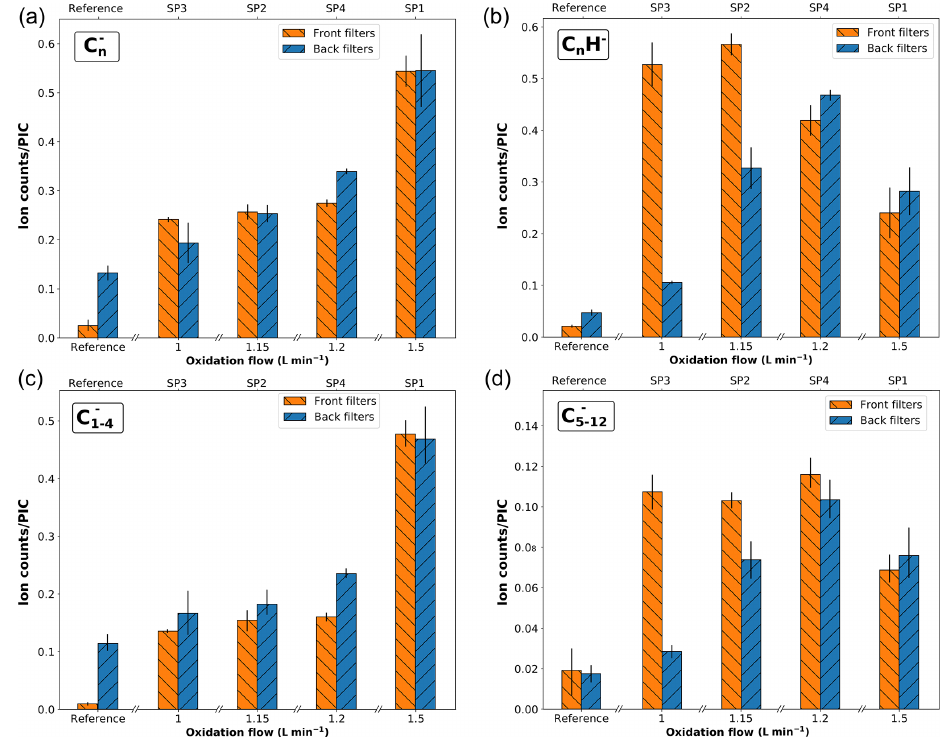
Figure 8. Variation in the signal of various markers, as derived from SIMS spectra. The panels represent the total peak areas of the following families: (a) C − n , (b) C n H − , (c) C − , and (d) C − . All values are normalized to the partial ion count (PIC) corresponding to the signal of 1–4 5–12 all selected